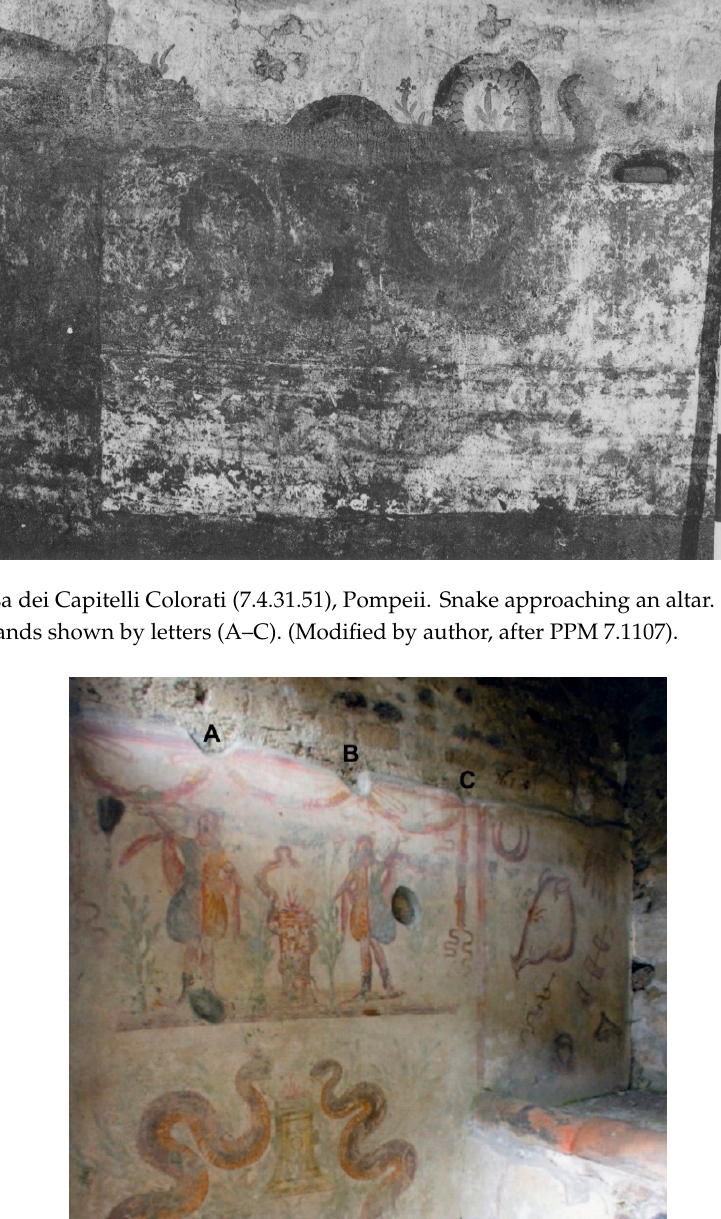
(Figure 6; Boyce 1937, cat. no. 278; Fröhlich 1991, cat. no. L86; Giacobello 2008, cat. no. 79; PPM 6.996– 1107). Above the snake is a garland segmented into two parts. At the crests of the segments, there are small holes that allowed for the insertion of nails to hang garlands directly atop the painted garlands, illustrating the interplay between the two- and three-dimensional aspects of the kitchen. While the instance on the part of those cooking for the household.